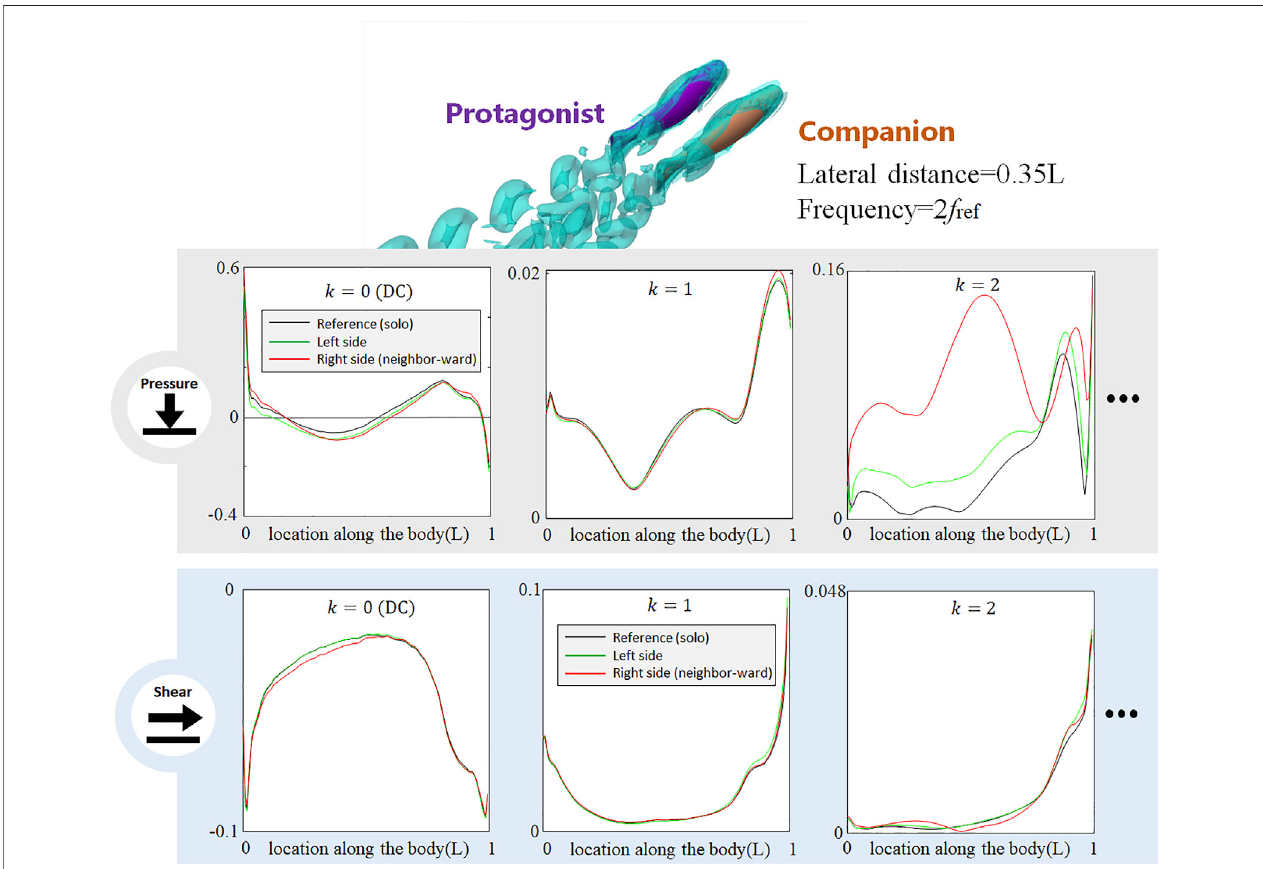
FIGURE 8 | Signal features sensed by the protagonist fi sh when an alongside neighbor uses double frequency as the protagonist fi sh. Full results are presented in Supplementary Figure S11 , ESM. One stress unit = 10 Pa.